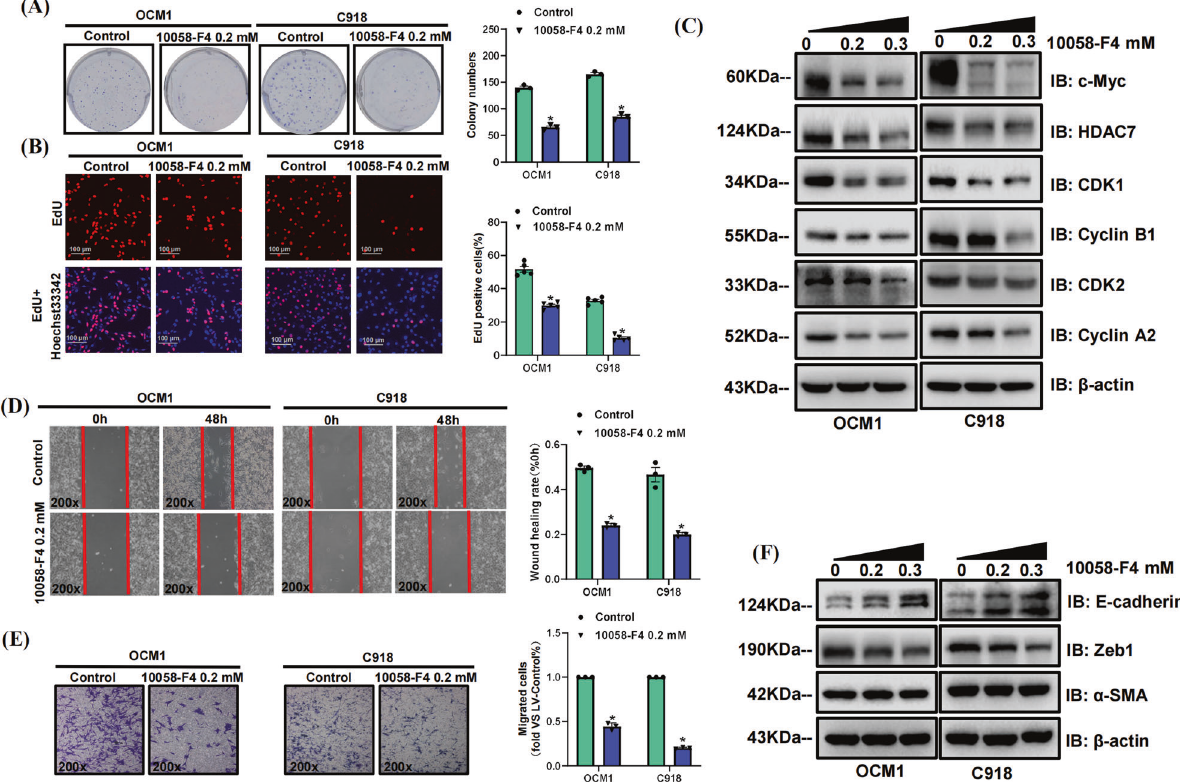
Fig. 7 10058-F4 suppresses the HDAC7/c-Myc signaling pathway to inhibit OCM1 and C918 cell proliferation and metastasis. OCM1/C918 cells were pretreated with 10058-F4 for 48 h. A Typical pictures and statistical analysis of the colony formation assay. B Typical pictures and statistical analysis of the EdU incorporation assay in OCM1/C918 cells. The results were calculated as the ratio of the number of EdU-positive cells (red fl uorescence) to the total number of Hoechst 33342 stained cells (blue fl uorescence). Scale bar, 100 μ m (inset). C Typical Western blot results of c-Myc, HDAC7, CDK1, Cyclin B1, CDK2, and Cyclin A2 in OCM1/C918 cells. D Typical pictures (×200) and statistical analysis of the wound healing assay. In wound healing assays, the migratory capacity was shown as the mean scratch area. The initial scratch area (0 h) was set to 100%. E Typical pictures (×200) and statistical analysis of the transwell assay. F Typical Western blot results of E-cadherin, Zeb1, and α - SMA in OCM1/C918 cells. β -actin was used as an internal control. Data are exhibited as the mean ± SD. Student ’ s t -test, * P < 0.05 vs. control group. Abbreviations: HDAC7 histone deacetylase